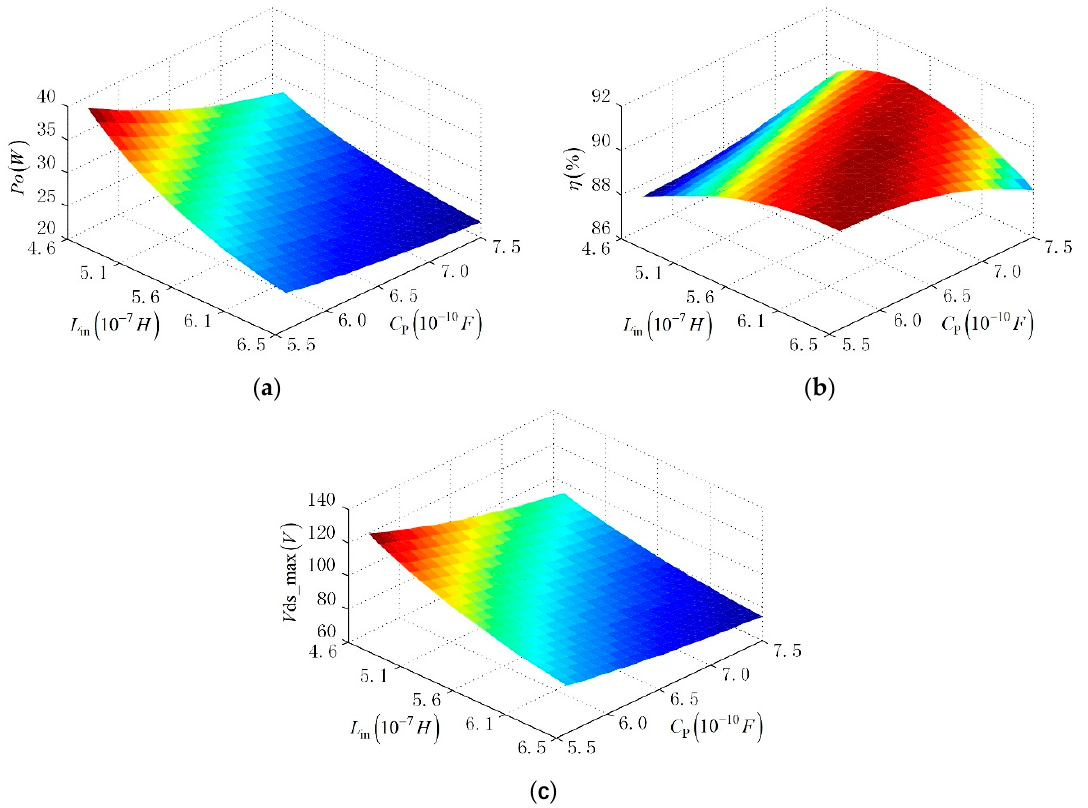
Figure 5. ( a ) Output power of PCL changing with L in and C p ; ( b ) output efficiency of PCL changing with L in and C p ; ( c ) peak voltage of PCL changing with L in and C p .